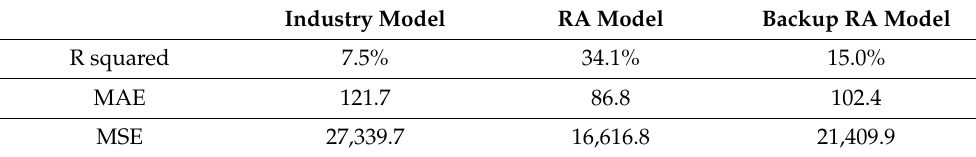
Table 14. RA Backup Model Point Estimate Summary Statistics.